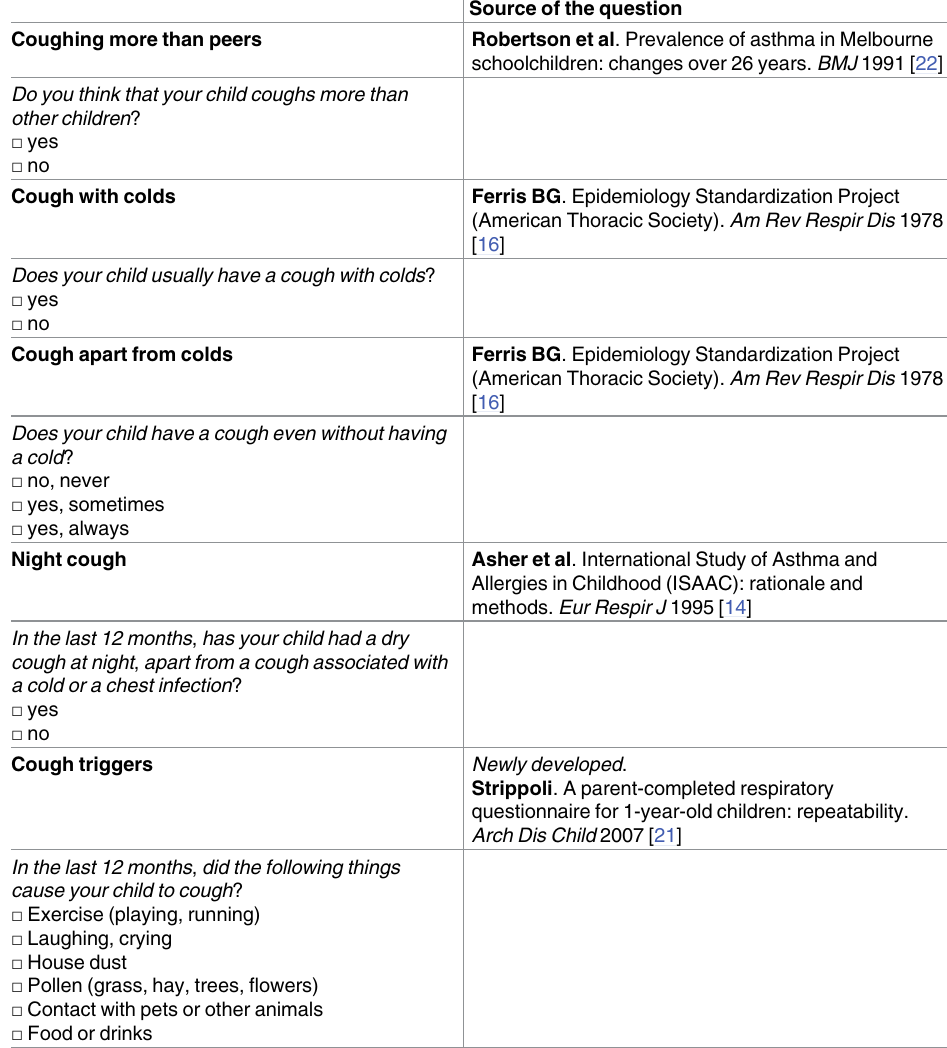
Table 1. Cough questions used in the LeicesterRespiratory Cohort